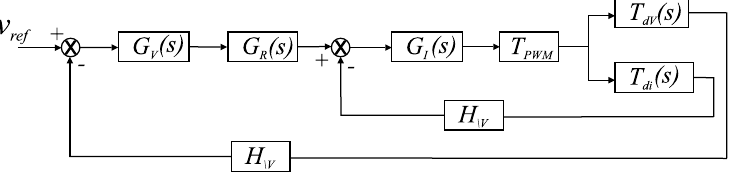
Figure 22. Resonant controller-based dual-loop control [100].